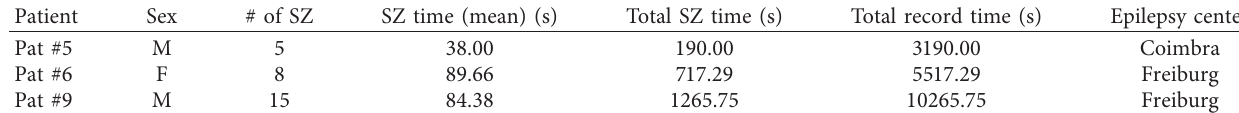
Table 1: Patients from European epilepsy database.